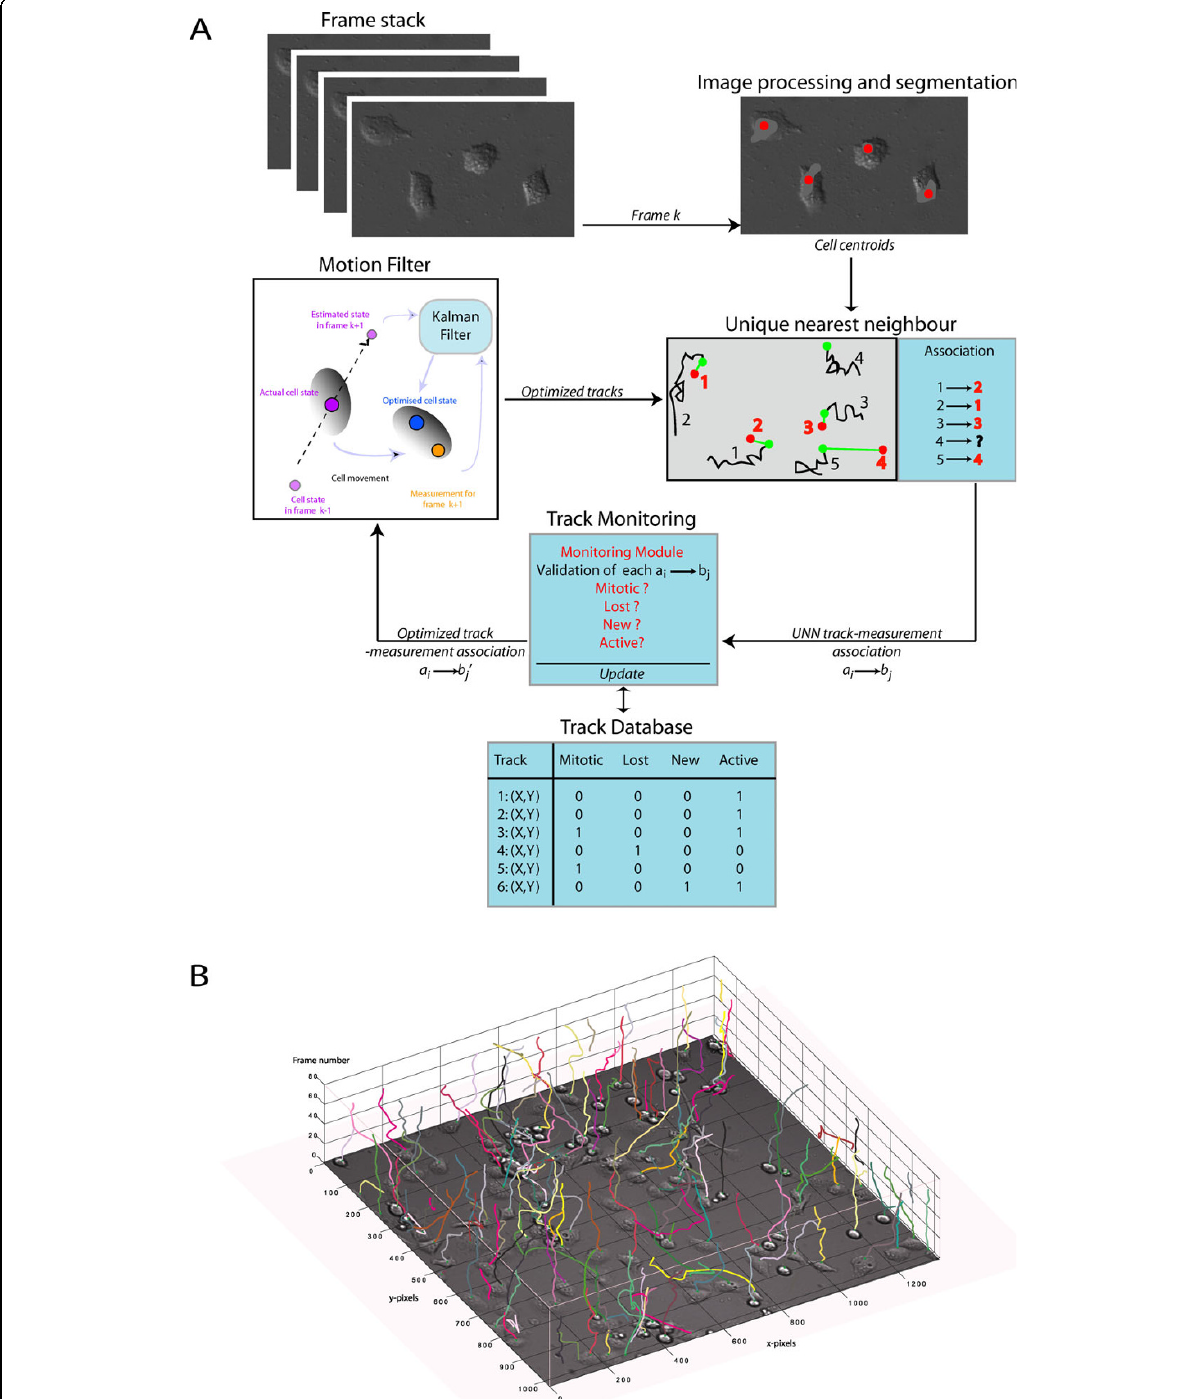
Figure 4 Overview of the tracking scheme . (A) In each iteration, the actual extracted cell centroids and the optimized state estimate from the Kalman filter process are used to compute the unique nearest neighbor for each track end. The unique nearest neighbor is processed in a monitoring module to check whether a cell division, cell death, or leaving of the cell out of view event might have occurred. The stored tracks are updated accordingly. All tracks that are still active are further processed: the tuple consisting of actual track end and associated unique nearest neighbor track (measurement) is used to make the next state ahead prediction using the Kalman filter. (B) Three-dimensional representation of the result of the migration analysis for a video sample derived by the automated tracking system. The extracted cell tracks are exemplarily plotted onto the first video frame. Each colored line marks the path of a single cell through the stack of images (video